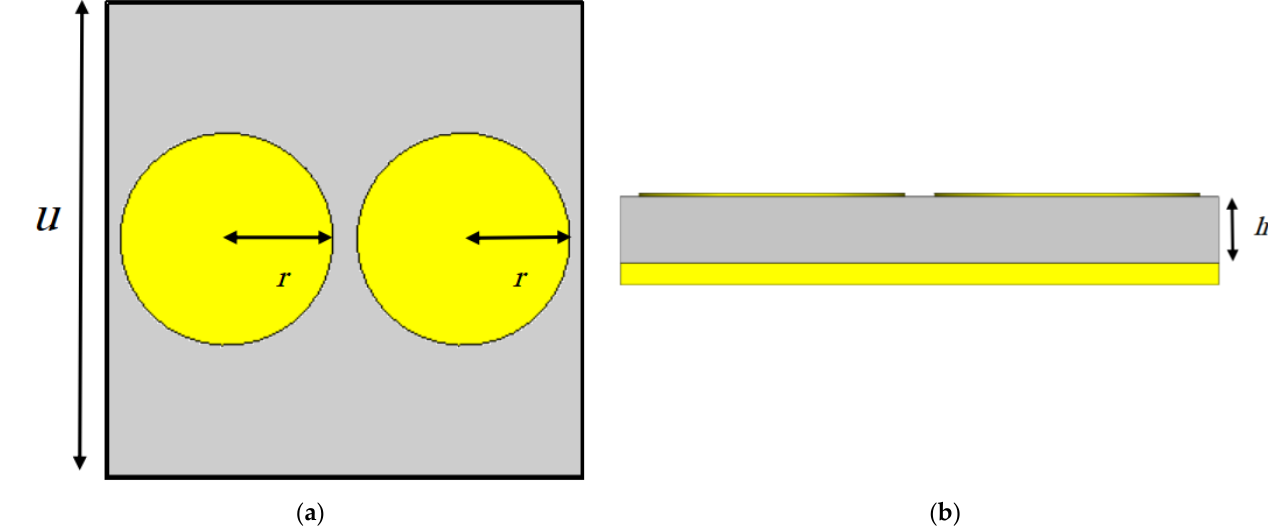
Figure 1. Proposed structure of TMA: ( a ) top view; ( b ) side view.